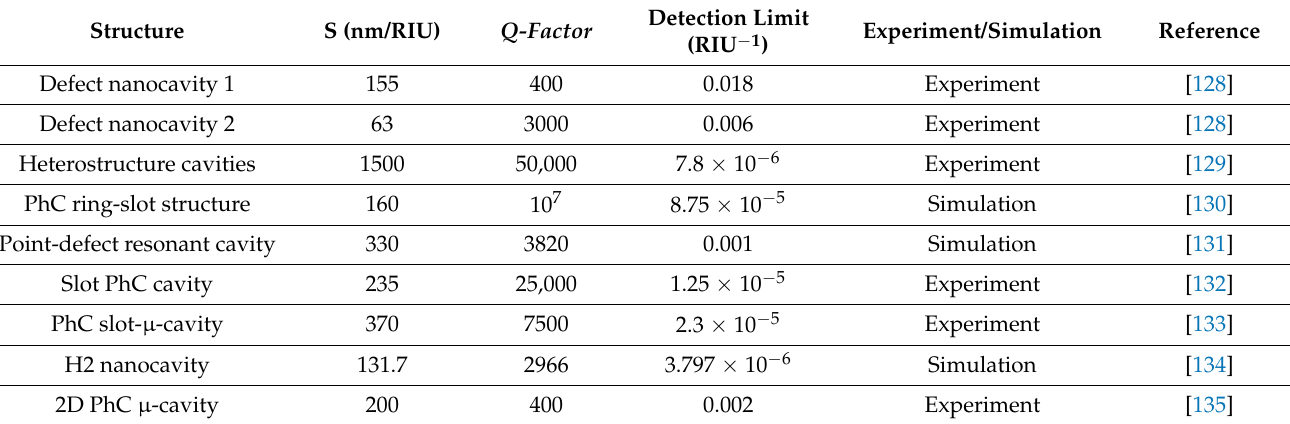
Table 3. Previously reported PhC-based refractive index sensing devices and their sensing